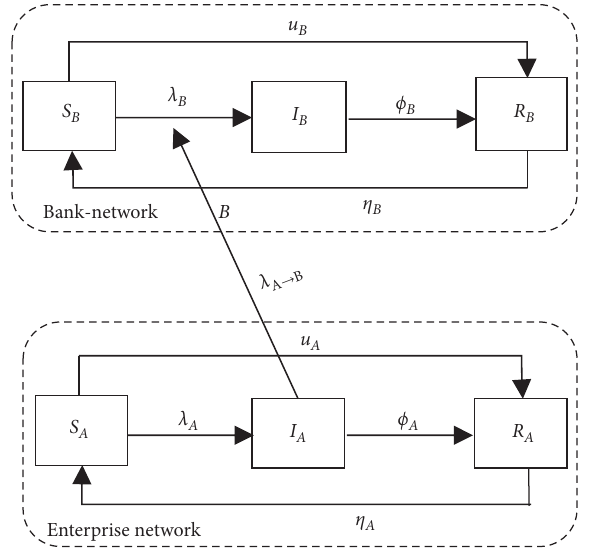
Figure 2: Credit risk transmission mechanism of bank-enterprise counterparties without bank withdrawal